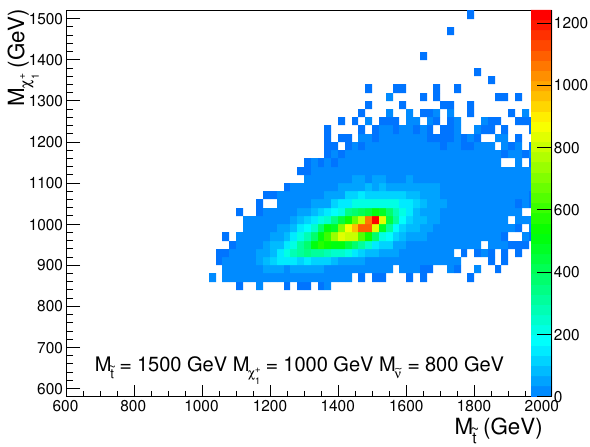
Figure 11 . The results of the 2-Dimensional mass reconstruction of stop quark and chargino when using the partons of the hard process as an input. The events have been generated for M ˜t = 1500 GeV, M = 1000 GeV and M ˜ ν = 800 x + 1